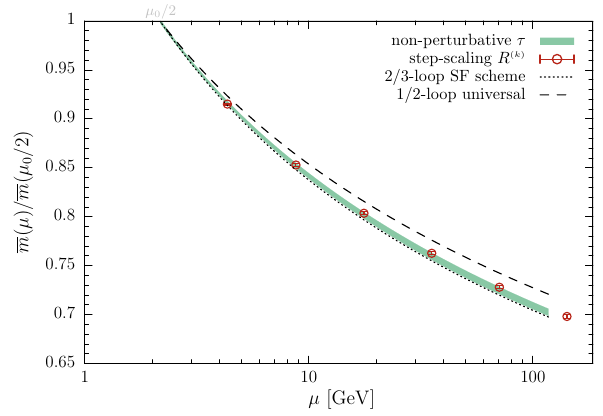
Fig. 2 RG evolution factor towards high energies from the lowest energy scale μ 0 / 2 reached with the SF scheme, given by the ratio m (μ)/ m (μ 0 / 2 ) . The green band is the result from our preferred deter- mination of the anomalous dimension, Eq. (3.12), in the region covered by our data, while the red points are the values of R ( k ) obtained from the step scaling in factors of 2 based on σ P . For the latter we have used the u-by-u FITB results with n s = 5 from Table 7. The scale setting to obtain μ in physical units uses μ 0 ≈ 4GeV, obtained from (cid:5) QCD in [31]. Perturbative predictions at different orders are also shown for comparison